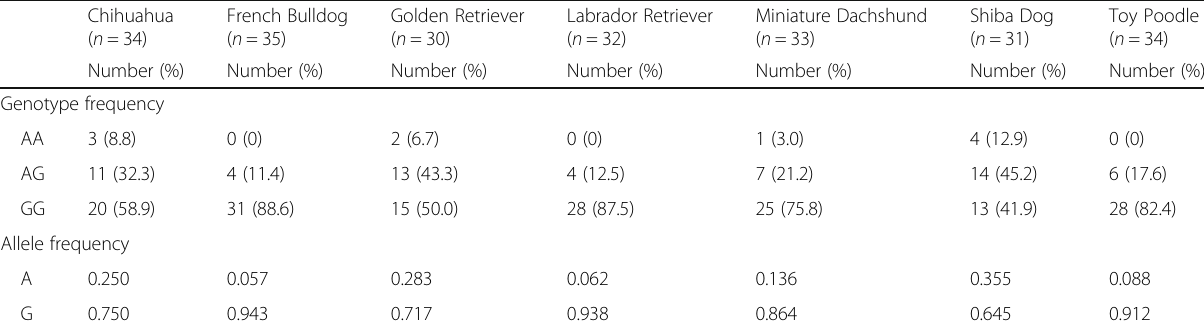
Table 1 Distribution of c.554 A > G SNP of CMAH in different dog breeds